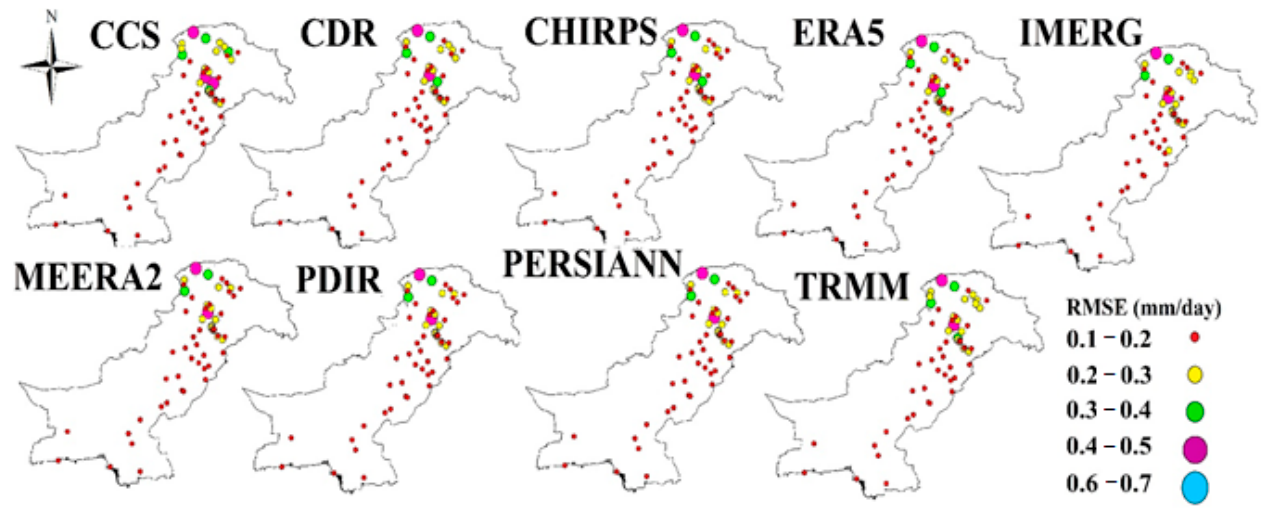
Figure 13. Spatial distribution of bias estimated for nine precipitation products in Pakistan.